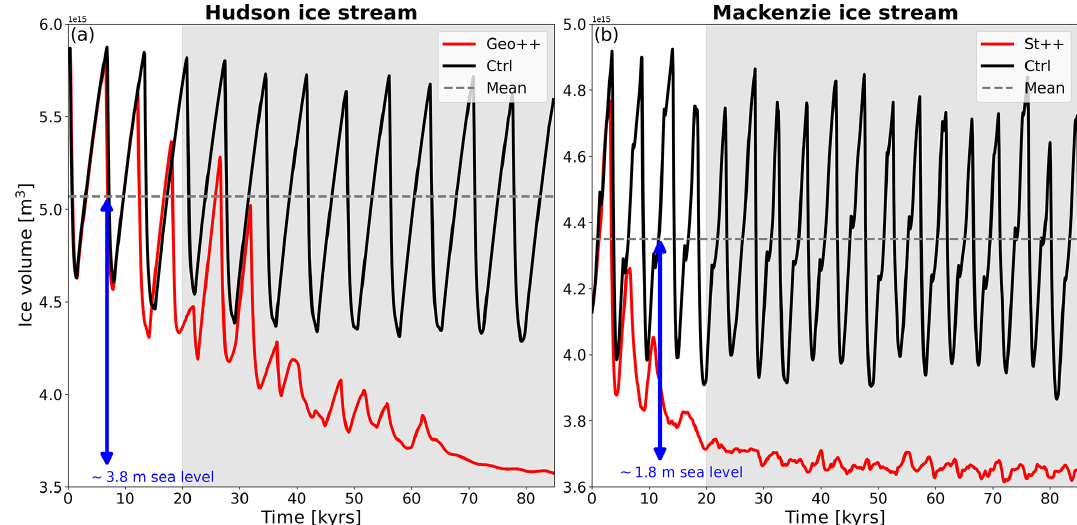
Figure 9. Comparison of ice volume evolution between the oscillatory and persistent ice stream regime for the (a) Hudson and (b) Mackenzie ice stream. Grey shading highlights the analysis